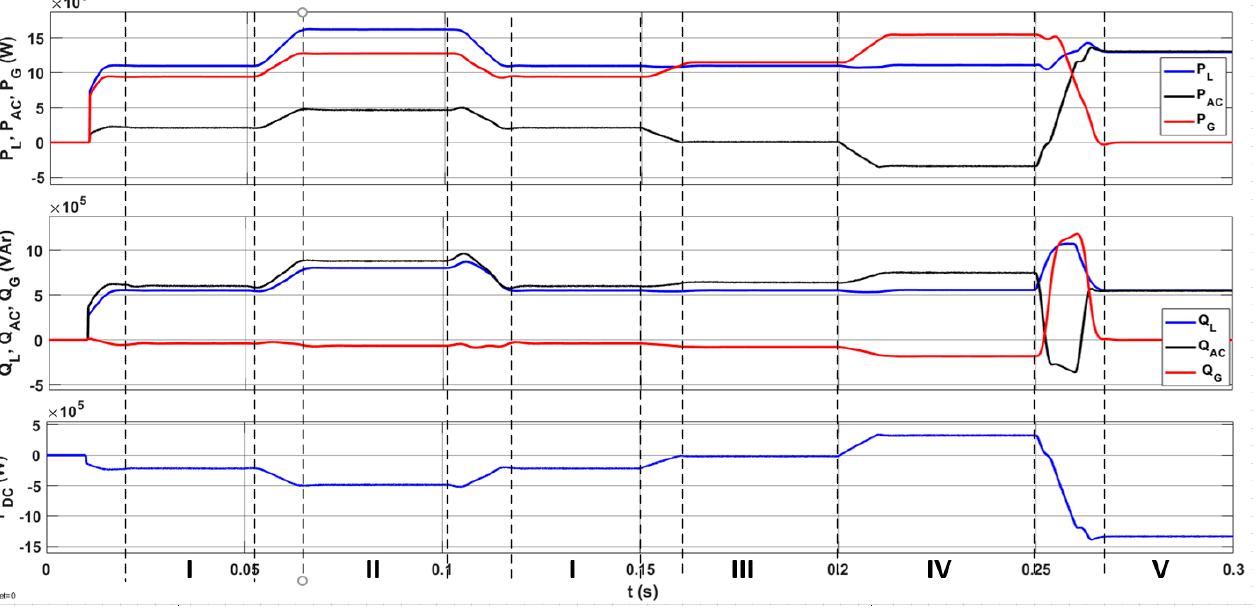
Figure 14. Energy processes with AC operation: waveforms of active power on the load, generator, and AC ( P L , P G , P AC ); reactive power on the load, generator, and AC ( Q L , Q G , P AC ), and voltage on the load ( U L ).